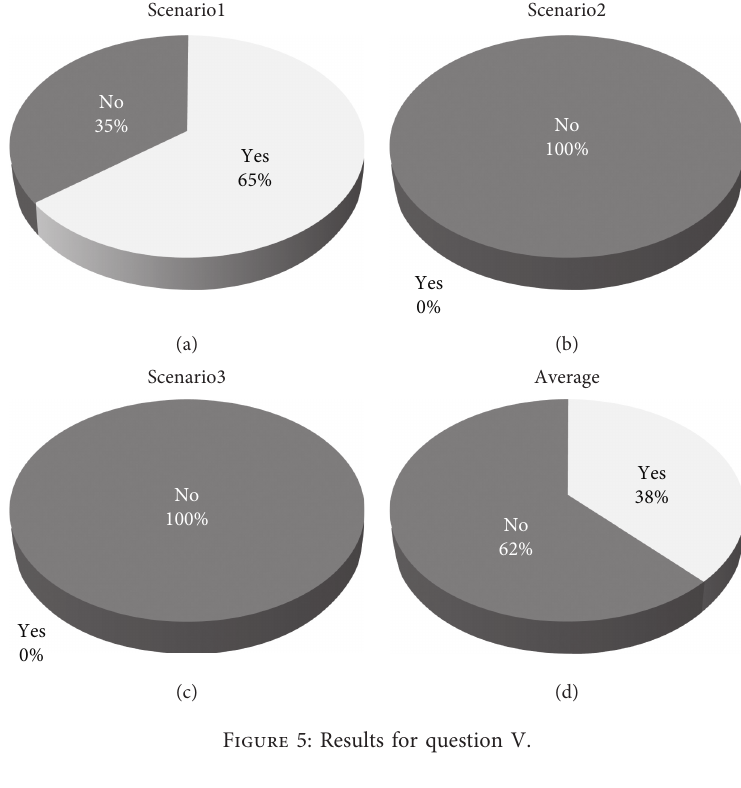
Figure 5: Results for question V.